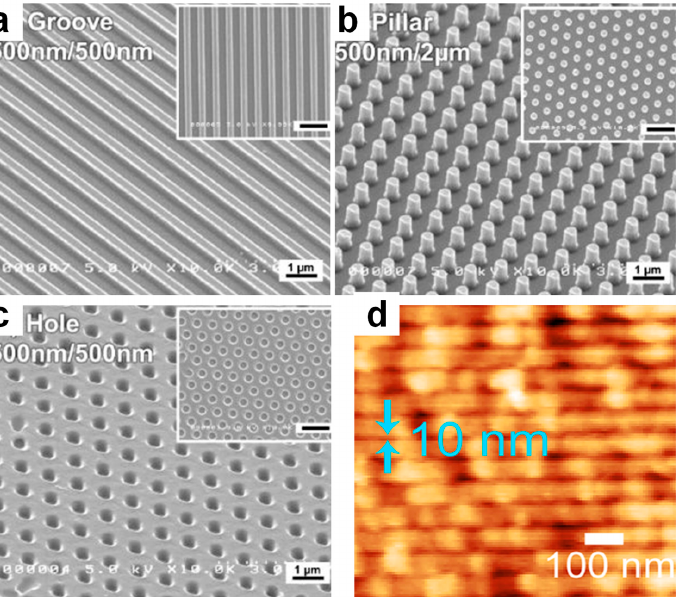
Figure 1. SEM images of different biopolymer-based patterns: ( a – c ) Cross-section and top (insets) SEM images emphasizing grooves ( a ), pillars ( b ) and holes ( c ) of gelatin crosslinked with genipin. The scale bar in the insets corresponds to 2 μ m. ( d ) AFM topography micrograph depicting high resolution single-line enzyme patterns made on a copolymer and displaying a width smaller than 10 nm. Adapted with permission from ref. [22] ( a – c ) and ref. [23] ( d ).